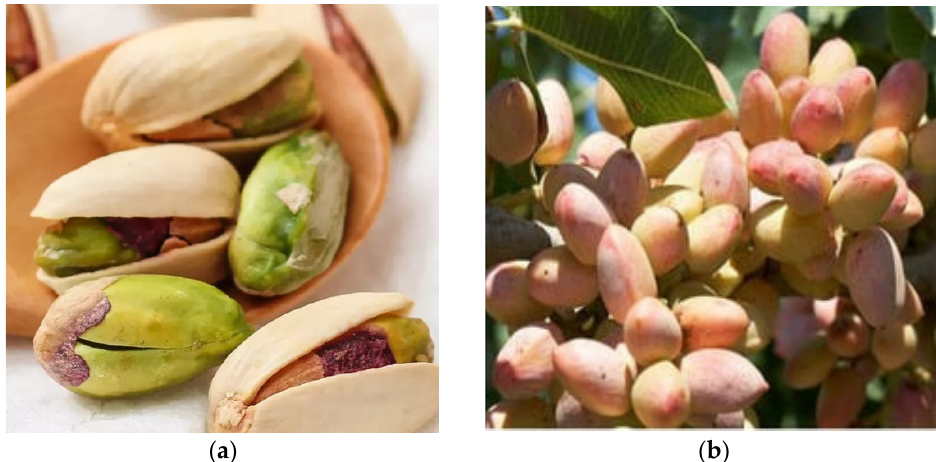
Figure 1. Pistacia vera L. open hard shell showing the red-purple skin ( a ); pistachio ripe fruit (hull) ( b ) [7].